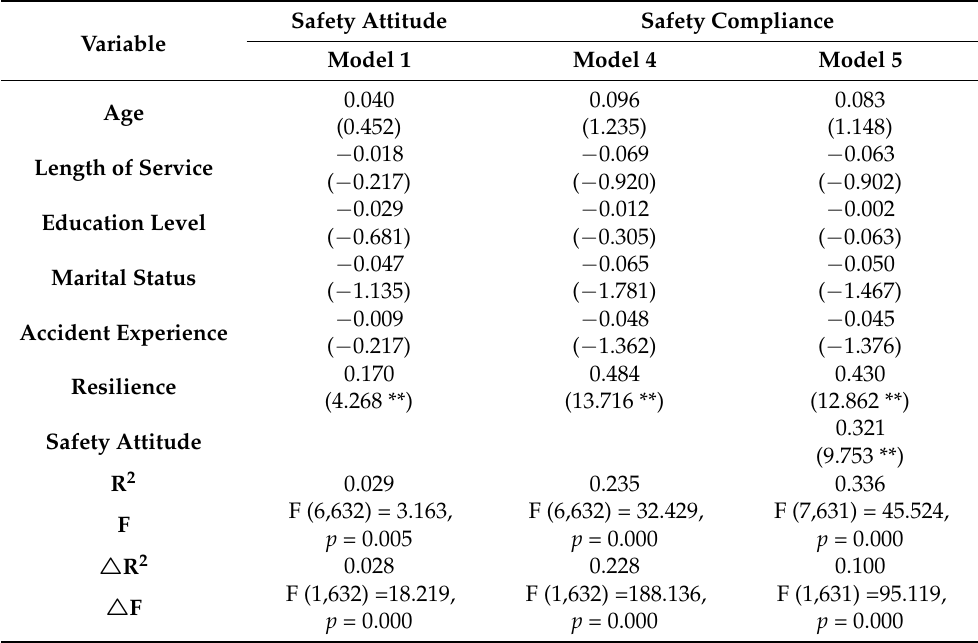
Table 17. Hierarchical regression of safety attitude mediating the impact of resilience on safety compliance (N = 639).